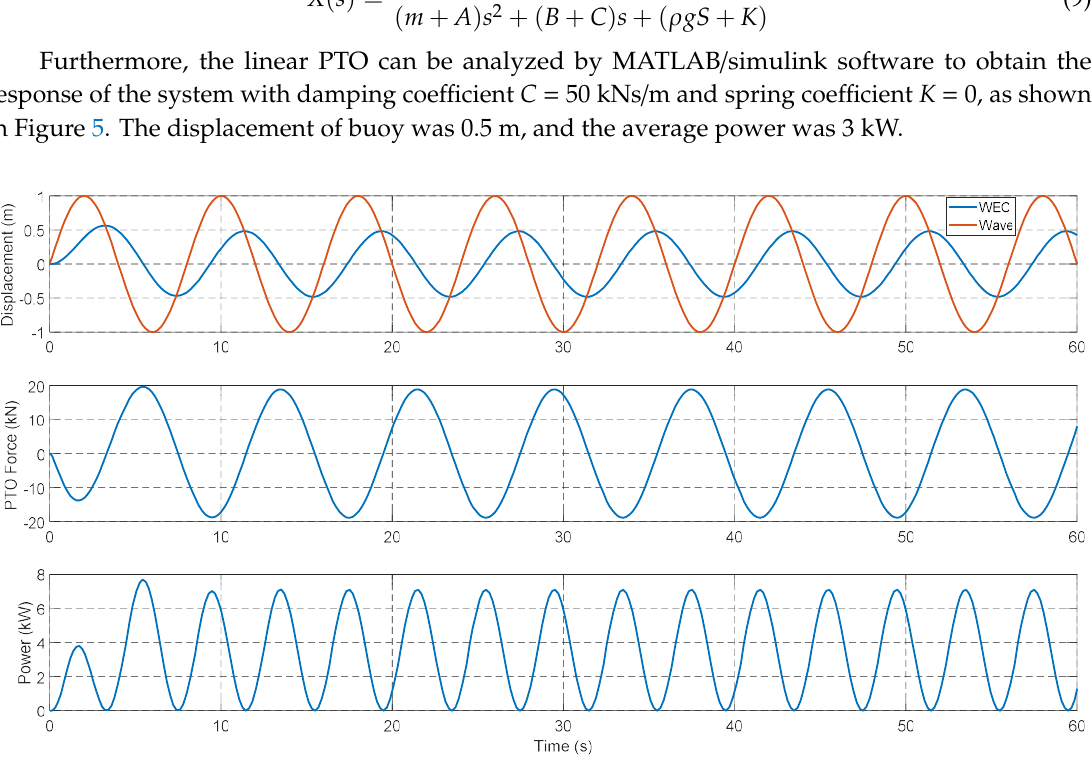
Figure 5. Top : Wave and WEC displacement, Middle : Power Take-Off (PTO) Force and Bottom : PTO Power for linear PTO characteristics C = 50 kNs/m.